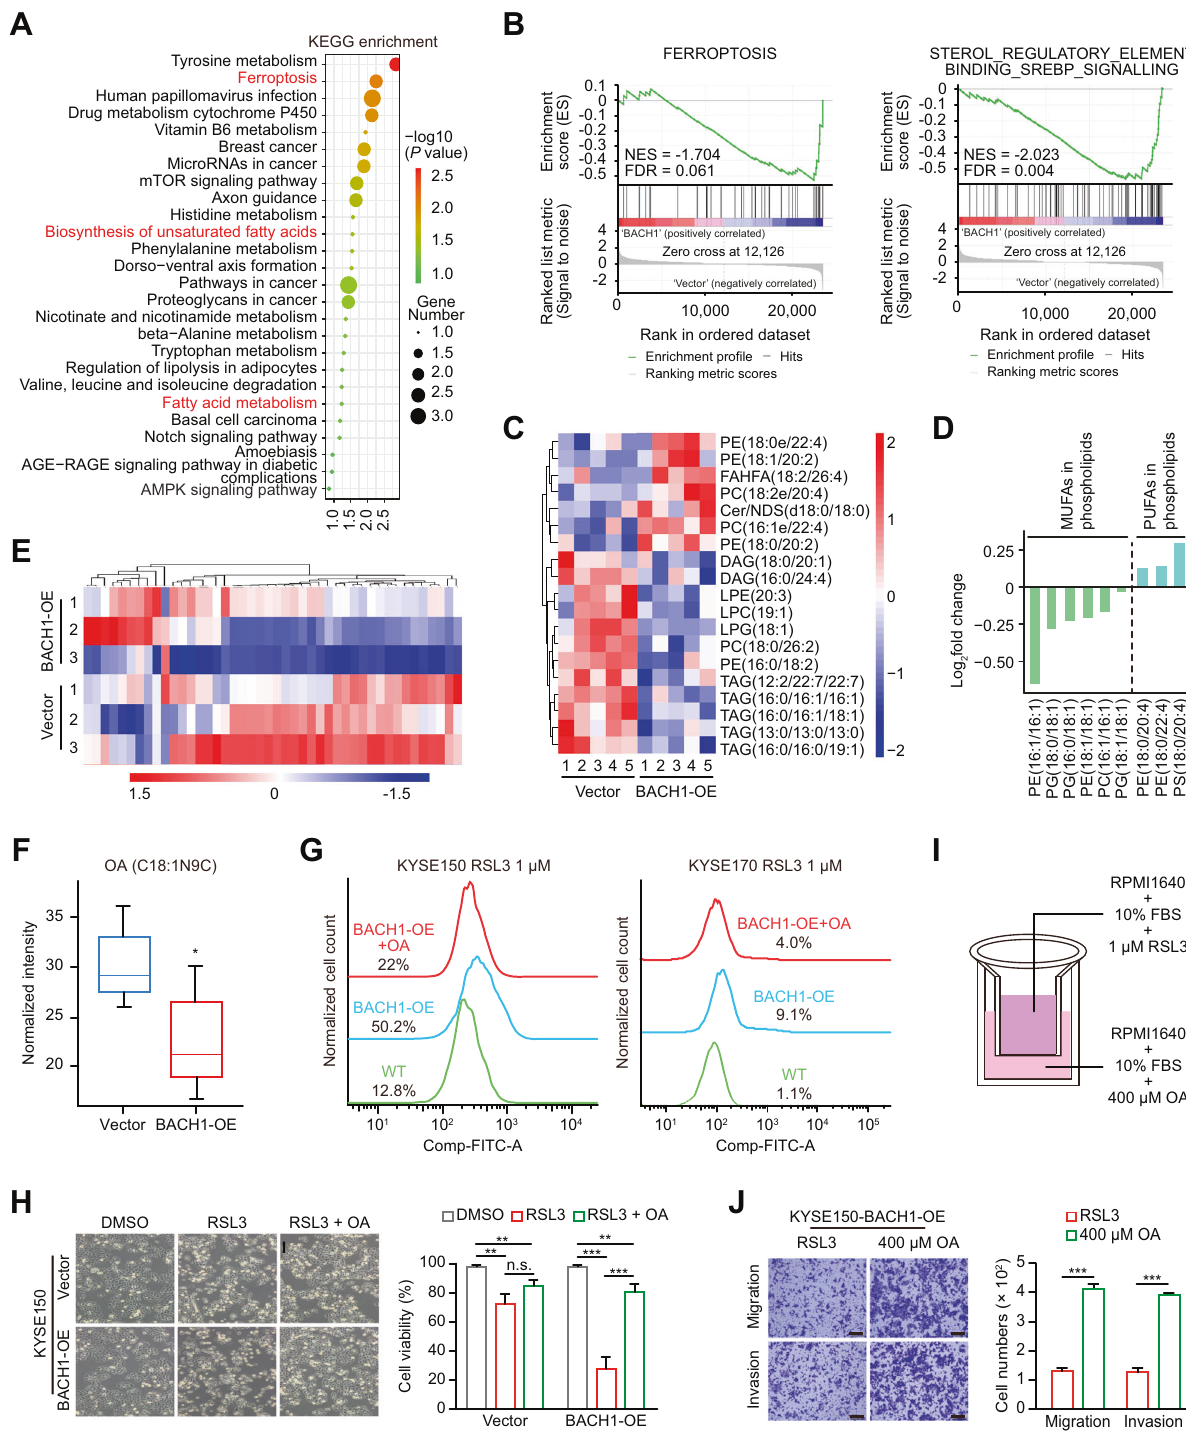
outcomes of patients with these tumors [25]. Therefore, it is necessary to fi nd some effective noninvasive biomarkers to assist with endoscopic ultrasound- and imaging-mediated discernment of cases with lymph node metastasis cases from early-stage patients. It is generally accepted that the immune system recognizes cell abnormalities early in tumorigenesis and initiates a response, autoimmunity, to tumor-associated antigens to produce a